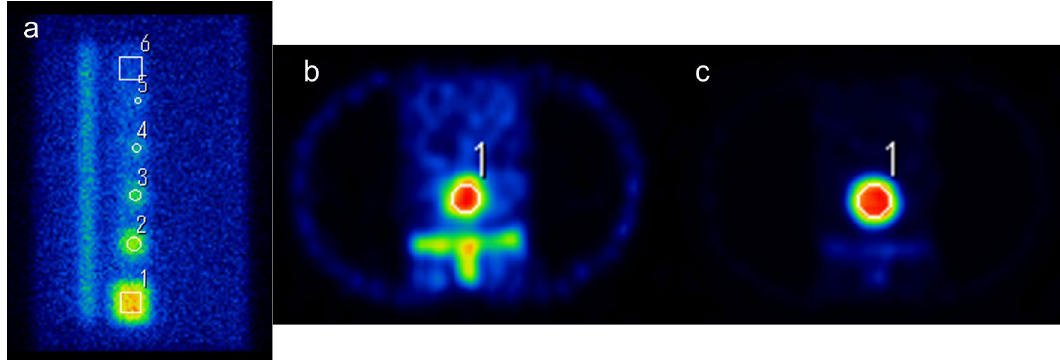
Figure 2. Planar and SPECT images calculating contrast to noise ratio (CNR) and the percent of the coefficient of variance (%CV). ( a ) Lateral view image with SwiftScan planar, transverse image of ( b ) tumor bone and ( c ) normal bone. Circle or rectangle ROI was set to each tumor and normal bones in planar and SPECT images using Prominence processor version 3.1 software (http://nm.jsrt.or.jp/blog.html) provided by Japanese Society of Radiological Technology’s subgroup Nuclear Medicine